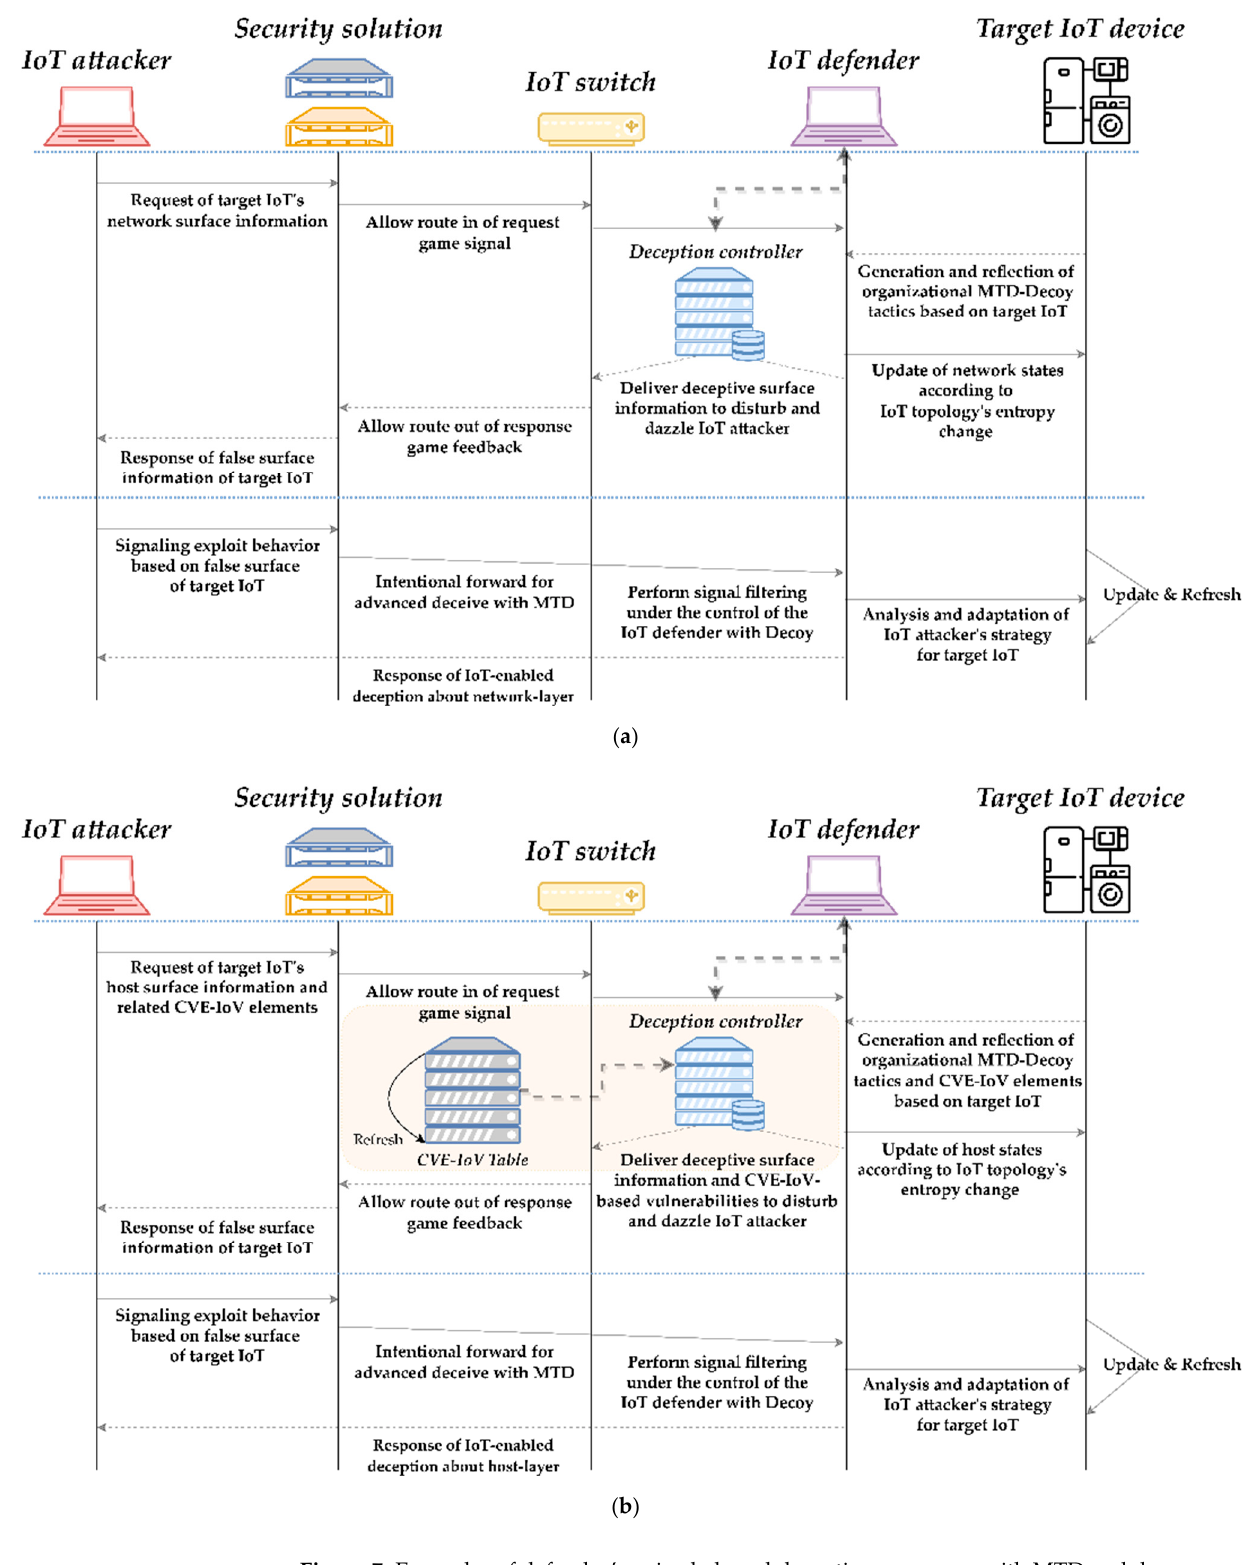
Figure 7. Examples of defender’s episode-based deceptive sequences with MTD and decoy concepts in IoDM. ( a ) Deceptive sequence beyond the network layer. ( b ) Deceptive sequence below the host